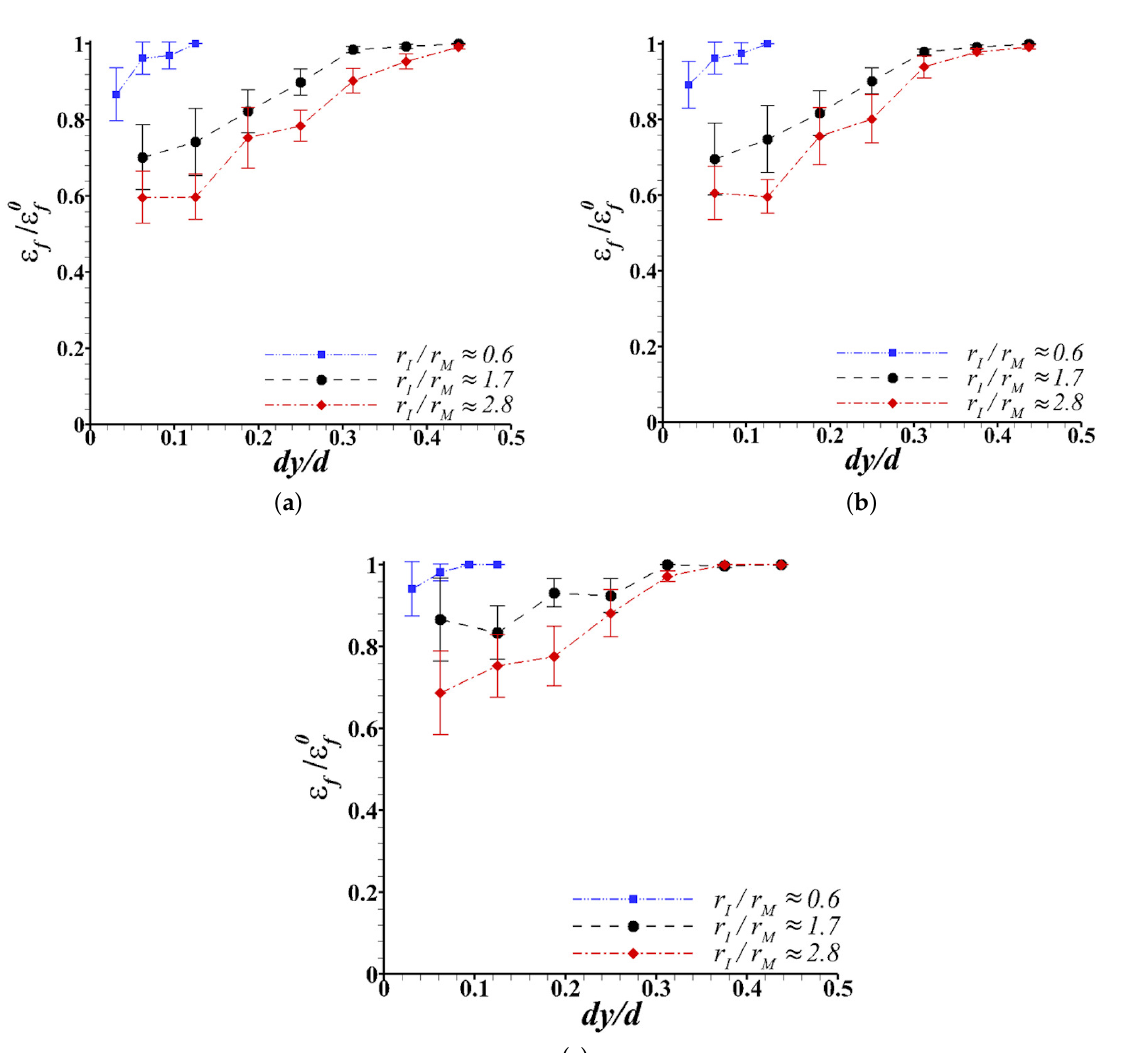
≈ 0.7 and 0 F ≈ 3.7 and N / σ 0